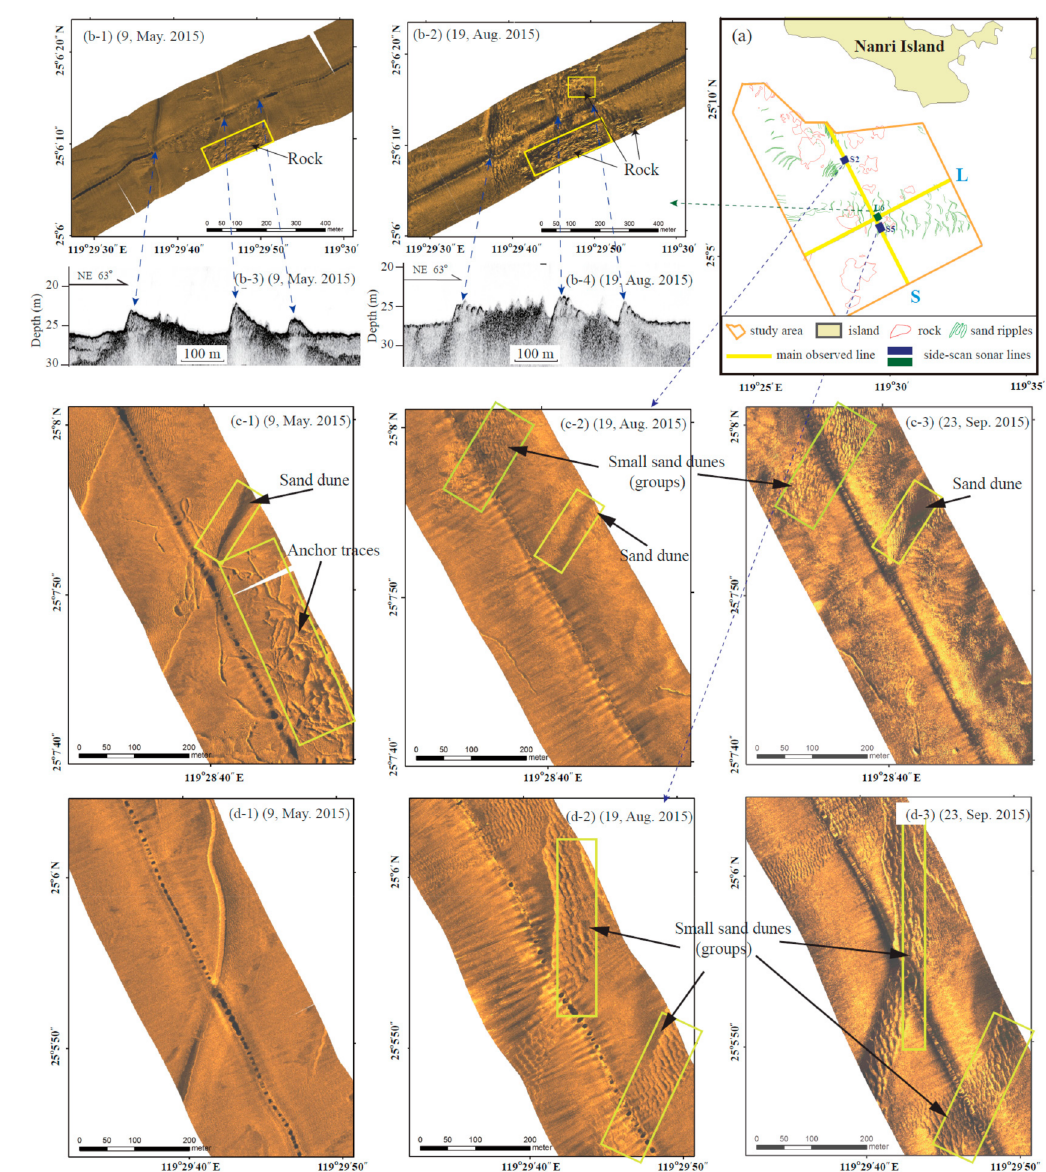
Figure 3. ( a ) Side-scan sonar profiles locations and the sonar images of L6, observed on ( b-1 ) 9 May 2015; ( b-2 ) 19 August 2015, and the corresponding seismic profiles ( b-3 , b-4 ); the sonar images of S2, observed on ( c-1 ) 9 May 2015; ( c-2 ) 19 August 2015; and ( c-3 ) 23 September 2015; and the sonar images of S5, observed on ( d-1 ) 5 September 2015; ( d-2 ) 19 August 2015; and ( d-3 ) 23 September